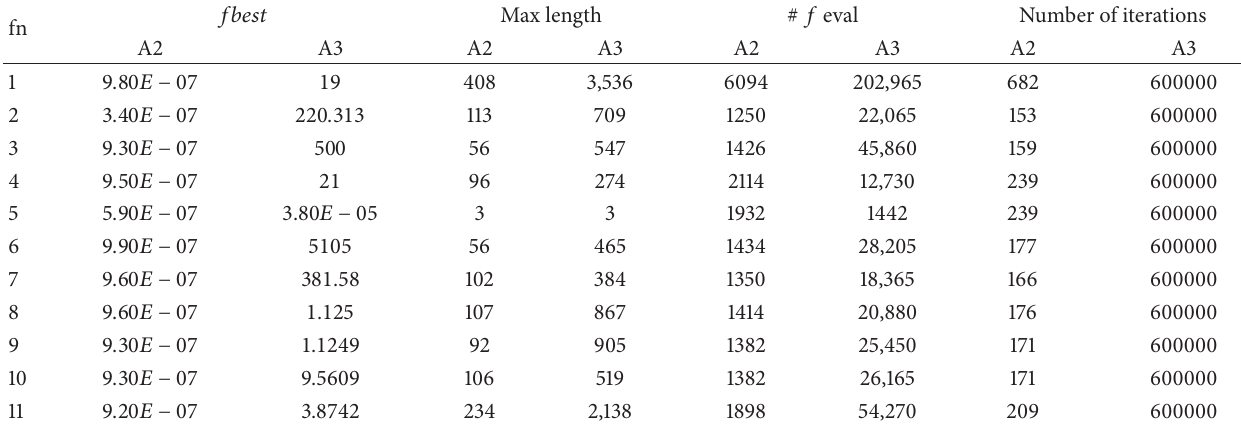
Table 2: The value of the best found, the maximum list length, the number of function evaluations, and the number of iterations from Ichida-Fujii A2 and Hansen A3 when 𝑛 = 20